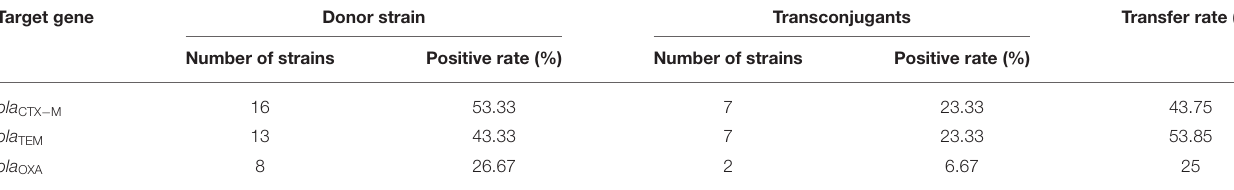
TABLE 9 | ESBLs-encoding genes of donor isolates and transconjugants. Target